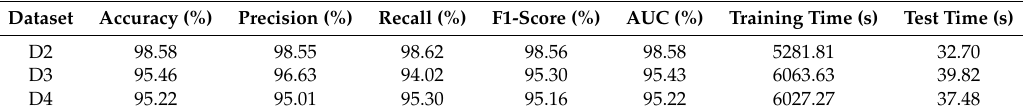
Table 8. The results of the proposed model on benchmark datasets.